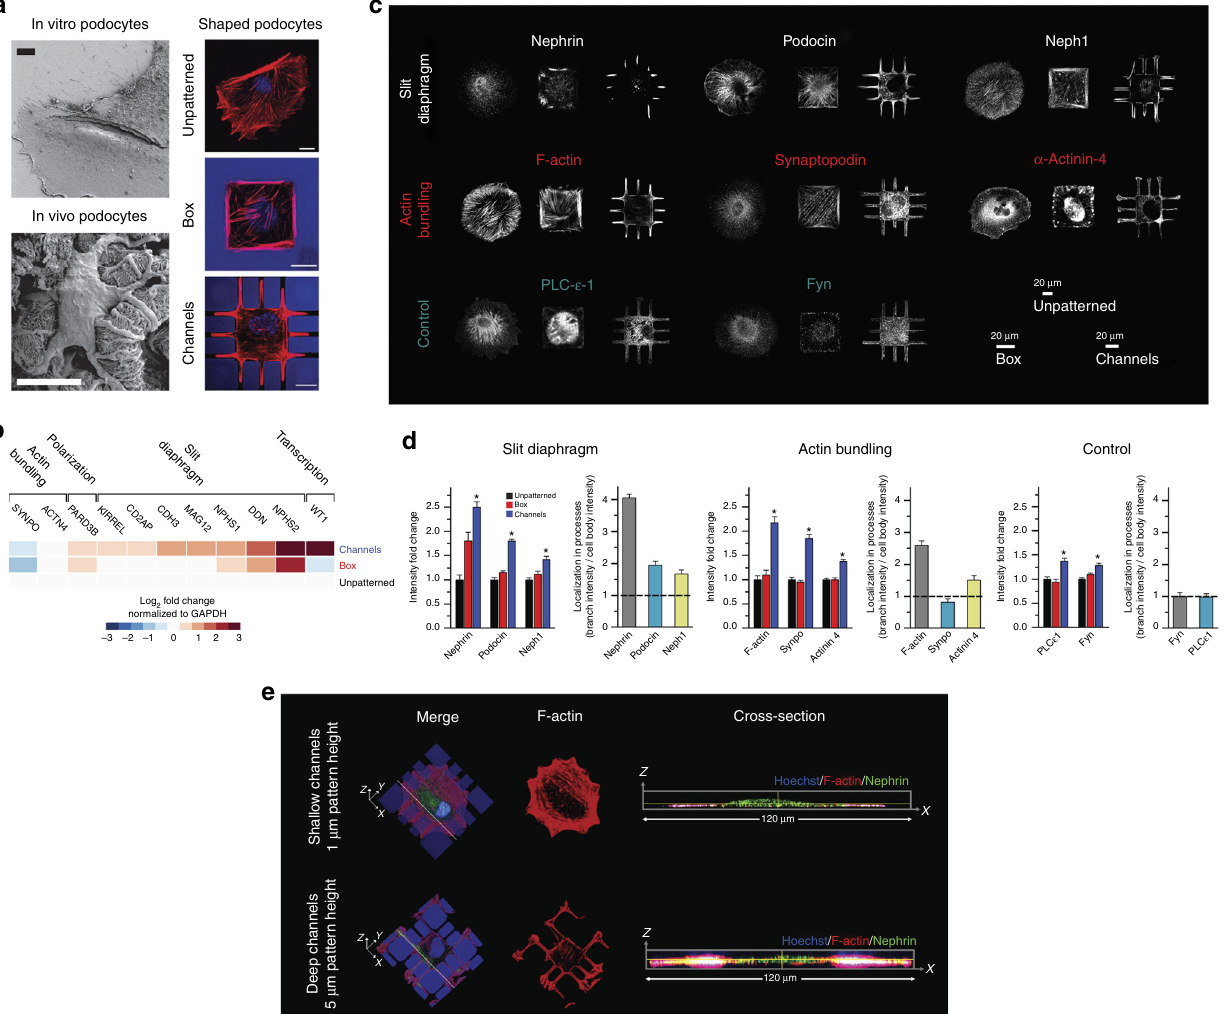
Fig. 1 Podocytes differentiate in response to shape signals. a (Left) Scanning electron micrograph of in vivo podocytes showing distinct processes that branch out of a central cell body; (Right) representative images of cells cultured on unpatterned glass, box, and channel micropatterns of the 3-D biochips. Cells were stained for F-actin (red) and nuclei (blue). All scale bars are 20 μ m. b mRNA expression levels measured by RT-PCR for physiologically essential proteins in podocytes revealed an increase in expression of nine out of eleven transcripts for cells plated on the channel micropatterns with a median increase of 87% (mean fold change of 2.8 ± 0.9; p < 0.05 vs. UNP; one-way ANOVA followed by a post hoc Tukey test). Cells in box patterns showed a median change of 7% with an increase in six and a decrease in fi ve transcripts (mean fold change of 1.4 ± 0.3; p = ns vs. UNP). Heatmap represents the average expression levels from four independent experiments with two slides in each group. c Representative immuno fl uorescence images of physiologically essential proteins in podocytes plated on unpatterned and patterned surfaces. The proteins are organized into “ slit diaphragm proteins ” nephrin, podocin, and neph1 (upper row), “ actin-bundling proteins ” F-actin, synaptopodin, and α -actinin-4 (middle row), and “ control proteins ” phospholipase-C- ε and Fyn (lower row). d Summary of whole-cell fl uorescence intensity fold change and localization ratio (ratio of fl uorescence intensity within peripheral processes vs. cell body) in micropatterned podocytes. Values given as mean ± SEM; n = 80, chosen randomly from eight different slides cultured independently at different times (* p < 0.01 vs. UNP; one-way ANOVA followed by a post hoc Tukey test). e Representative immuno fl uorescent confocal volume scans of podocytes cultured on shallow (1 μ m) and deep (5 μ m) channel patterns showing nephrin (green), F-actin (red) and nuclei (blue). On biochips with shallow micropatterns, cells did not produce high aspect ratio processes enriched for nephrin. In contrast, clear enrichment was observed in deep channels. Hence, 3-D shape is necessary for the localization